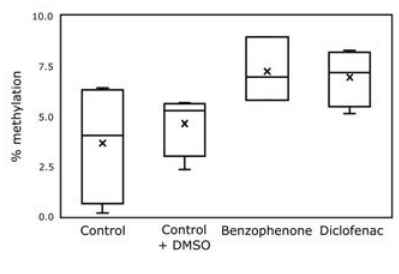
Figure 2. DNA methylation (% of total DNA) of G. pectinatus measured by ELISA exposed to the 2 chemicals over four gener- ations (84 days).